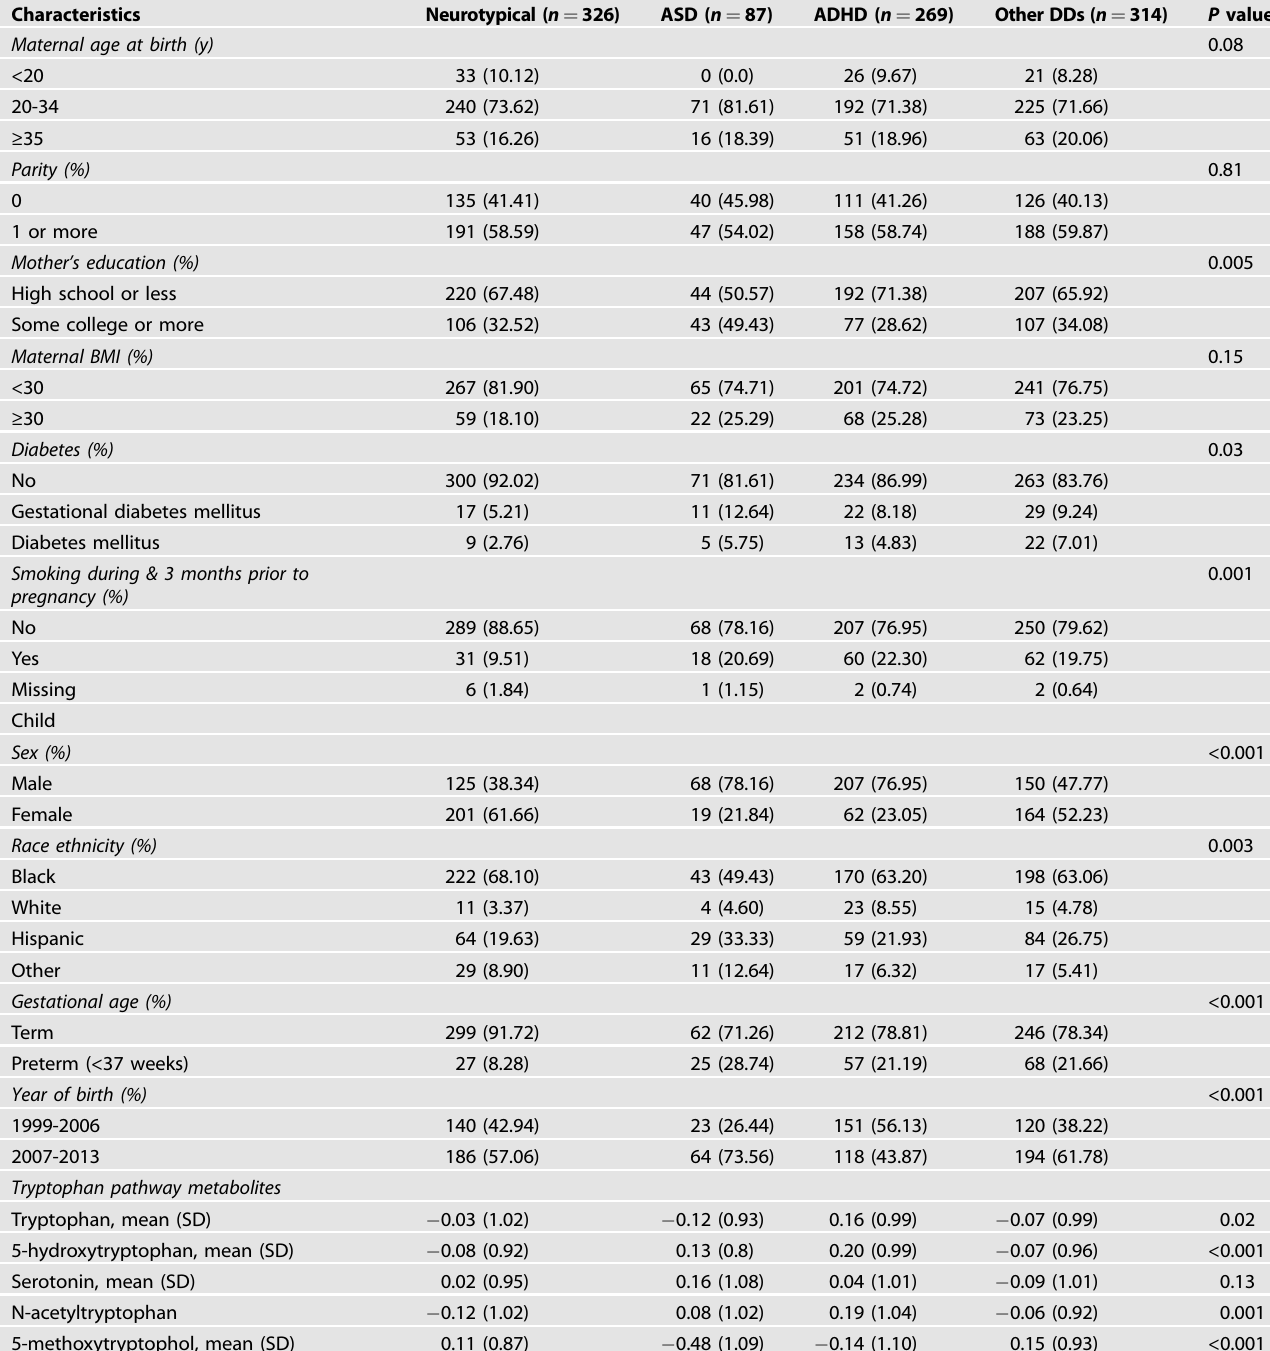
Table 1. Maternal and child characteristics according to child physician-diagnosed